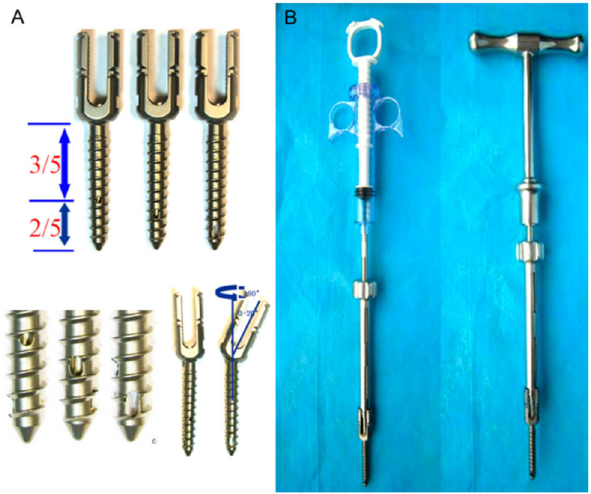
Figure 1 - (A) The design of the CICPS; (B) The CICPS connects to the specially designed bone cement syringe and the T-shaped handle through an